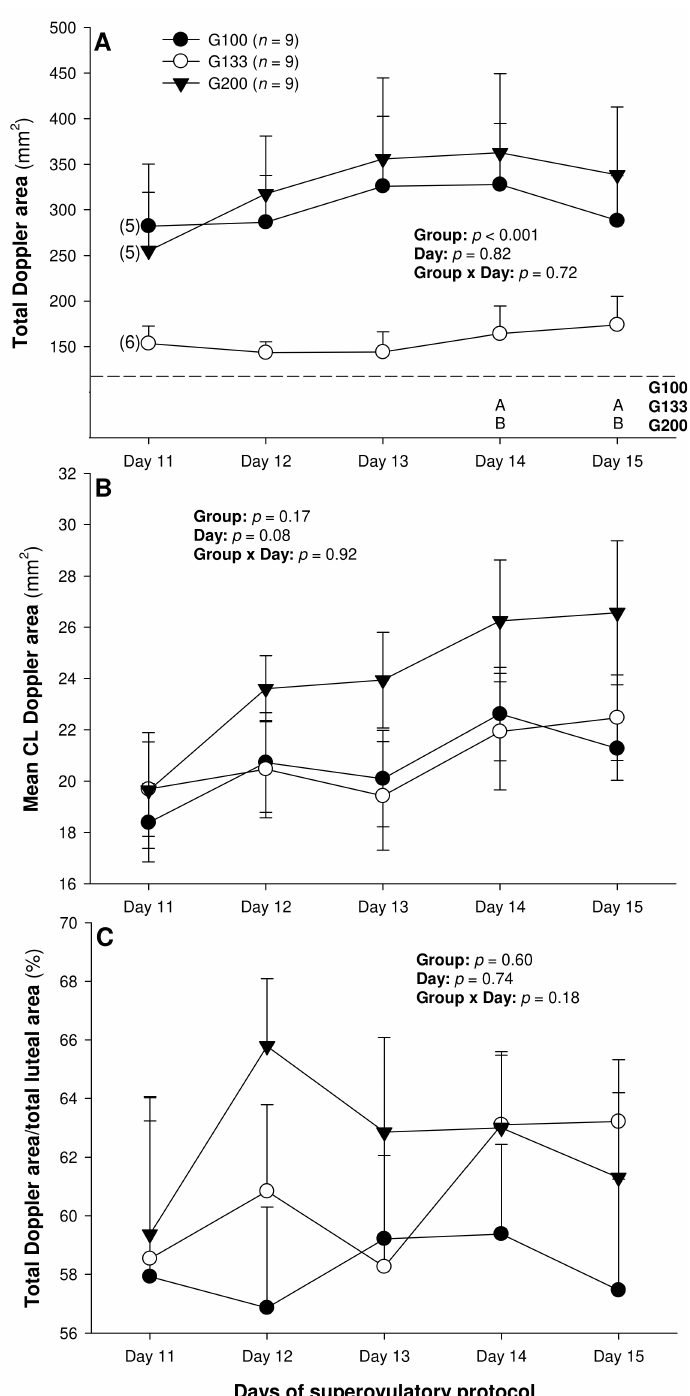
Figure 3. Total ( A ) and mean ( B ) luteal Doppler area as well as luteal vascularization percentage (total Doppler area/total luteal area × 100%) ( C ) from Day 11 (1 or 2 days after ovulation or beginning of luteogenesis) to Day 15 (day of embryo recovery) of the superovulatory protocol in Santa In ê s ewes submitted to superovulatory treatment with 100 (G100), 133 (G133), or 200 (G200) mg of pFSH given in eight decreasing doses. Numbers in parentheses (panel A ) denote the numbers of ewes in which CL were detectable ultrasonographically on Day